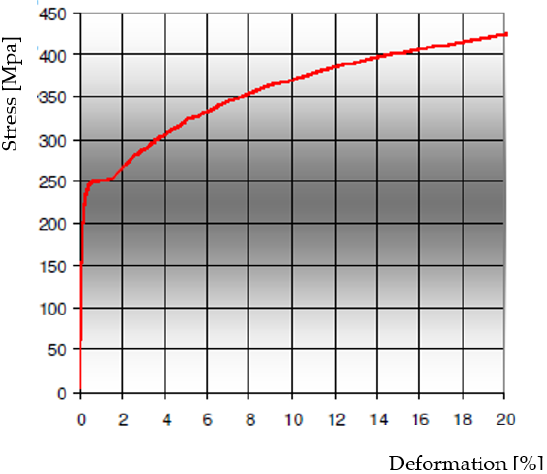
Figure 37. Tensibility diagrams of KOHAL E210 IZ.